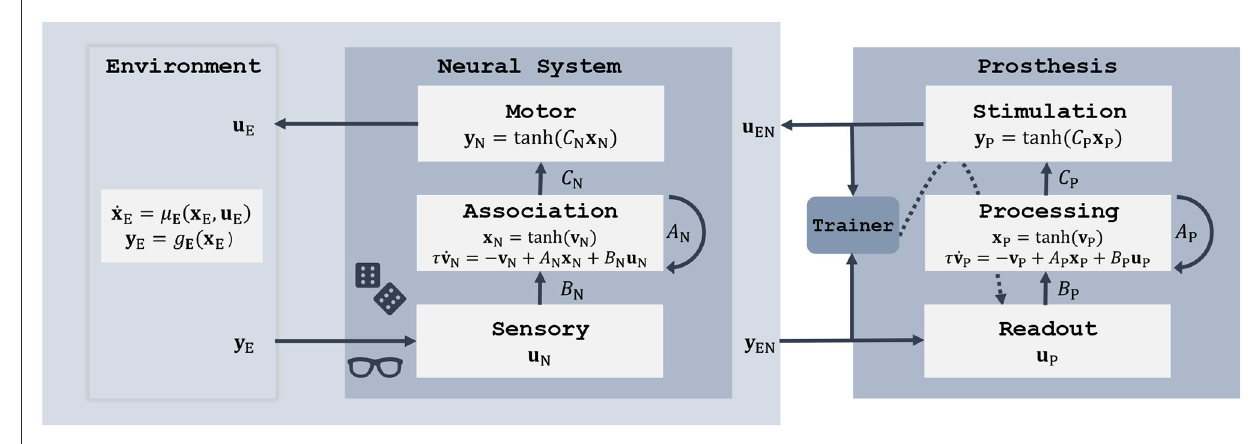
FIGURE3 Framework to model a perturbed neural system in interaction with its environment (left) and restoring its performance by training a secondary controller (right) .